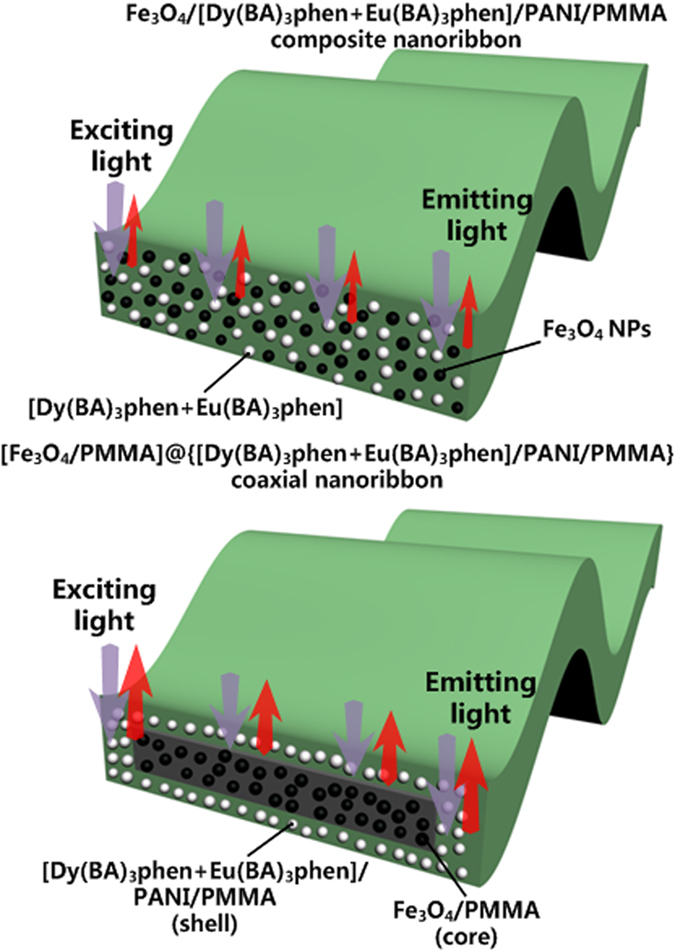
Schematic diagrams of the situation of the exciting light and emitting light in the Fe3O4/[Dy(BA)3phen+Eu(BA)3phen]/PANI/PMMA composite nanoribbons and [Fe3O4/PMMA]@{[Dy(BA)3phen+Eu(BA)3phen]/PANI/PMMA} coaxial nanoribbons.